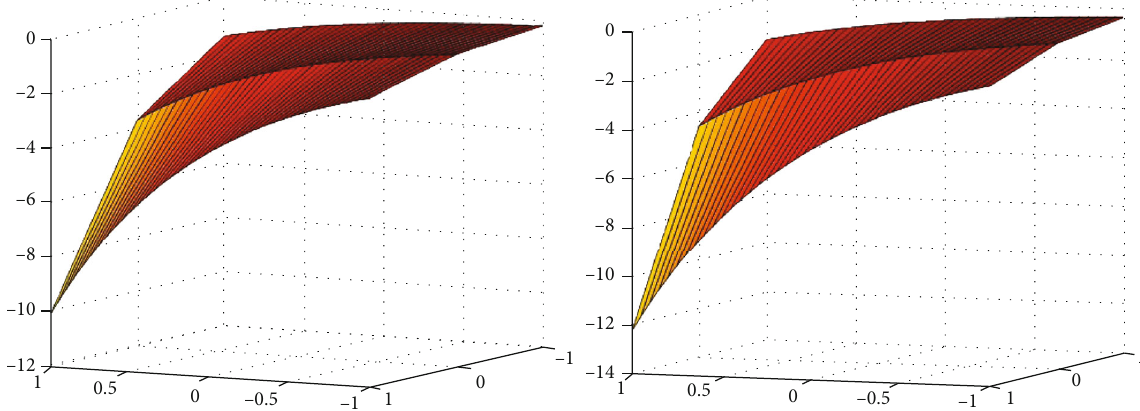
Figure 11: The fractional order of α = 0 : 8 and 0 : 6 of Problem